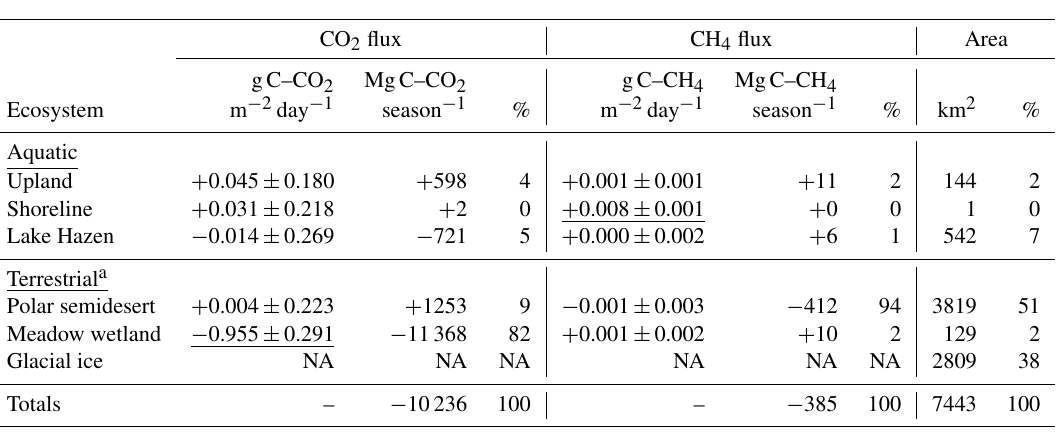
Table 4. Comparison of the daily net exchange of carbon dioxide (CO 2 ) and methane (CH 4 ) between high Arctic terrestrial and freshwater ecosystems and the atmosphere in the Lake Hazen watershed during the growing seasons (June–August) of 2005 and 2007–2012. Positive values represent net emission of a gas to the atmosphere. Underlined values denote statistical differences of daily fluxes from other ecosystem types for each gas (linear mixed model; α = 0.05; see Methods). The total and percent growing season exchange of each gas and ecosystem is also shown, as is the surface area of each ecosystem. Measurements that were not available were assumed to be zero and are denoted by